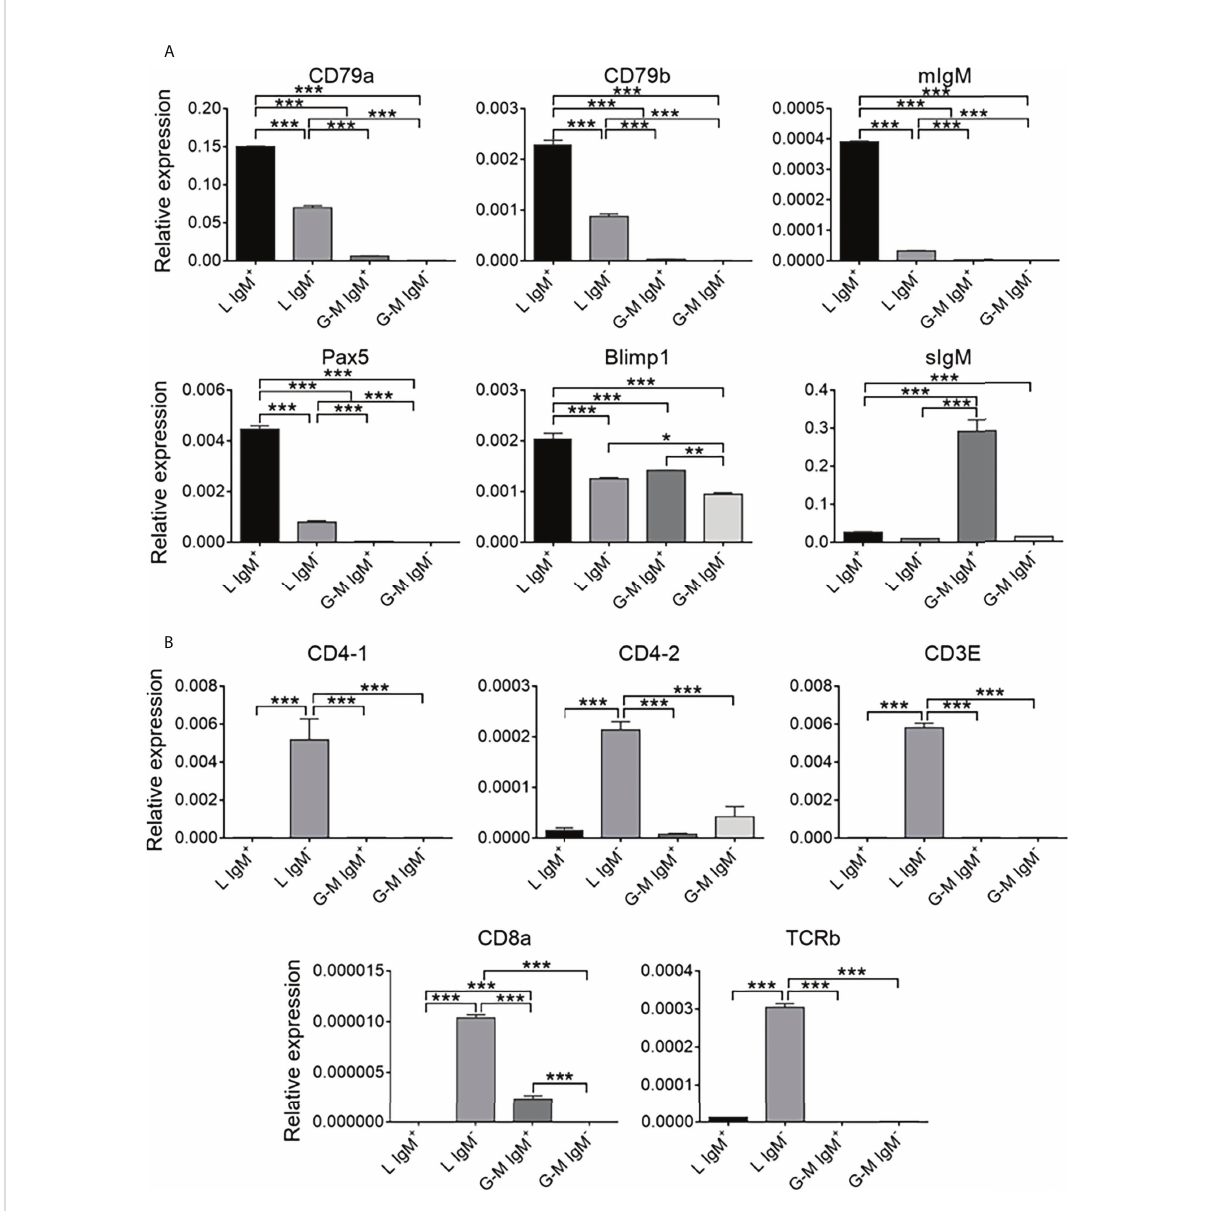
FIGURE 3 Comparison of the expression of B-cell- and T-cell-related genes among tilapia L-gate IgM + , L-gate IgM – , G-M gate IgM + , and G-M gate IgM – cells from anterior kidney (AK) leukocytes. (A) The expression patterns of B cell-related genes: CD79a , CD79b , membrane IgM ( mIgM ), paired box protein 5 ( PAX5 ), B-lymphocyte-induced maturation protein 1 ( BLIMP1 ), and secreted IgM ( sIgM ). (B) The expression patterns of T-cell- related genes: CD4-1 , CD4-2 , CD3E , CD8a , and TCRb ( n = 5 fi sh). Asterisks indicated signi fi cant differences, where * p ≤ 0.05, ** p ≤ 0.01, and *** p ≤